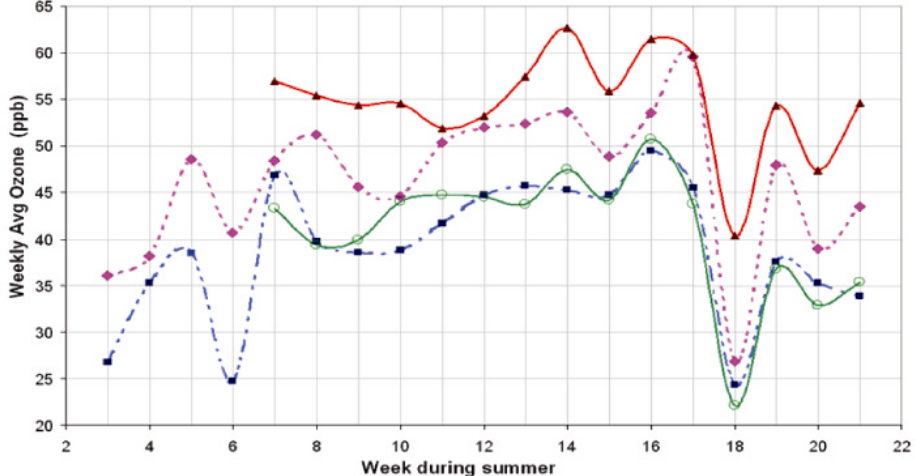
FIGURE 9. Comparison of weekly average ozone concentrations at three western-boundary sites and a site within Yosemite Valley. The Turtleback Dome site is on the rim and well above the valley floor. The other three sites are lower and about the same elevation. Legend: triangle – Turtleback Dome; diamond – Camp Mather; square – Wawona Valley; open circle – Yosemite